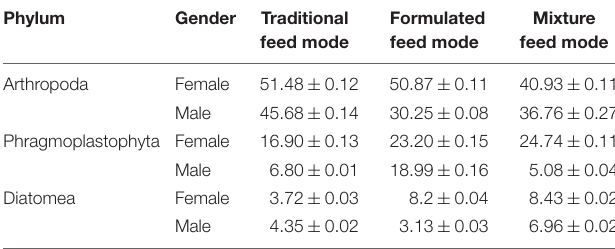
TABLE 2 | Operational taxonomic units (OTUs) of stomach content abundance exceeding 5% in crab samples reared under three feeding modes (%). Phylum Gender Traditional